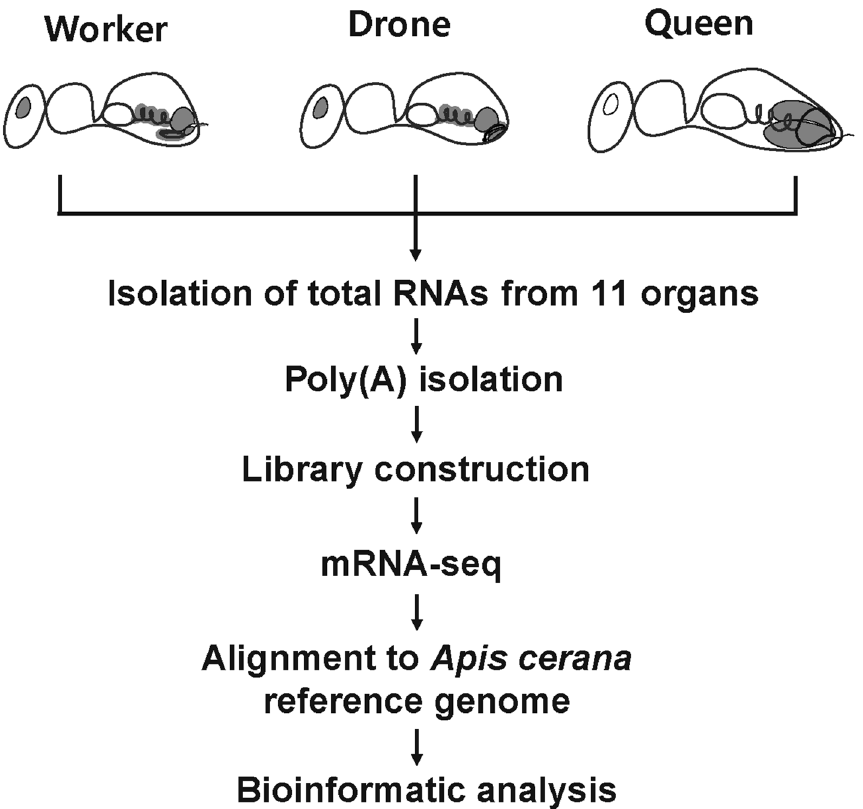
Figure 1. Schematic overview of the experimental design and analysis pipeline. Organs collected directly from adult honeybees for mRNA-seq: brain, ventriculus, rectum from workers and drones, venom gland from worker, and reproductive organs (testis, mucus gland, and ovaries) from three castes. The collected organs shown in